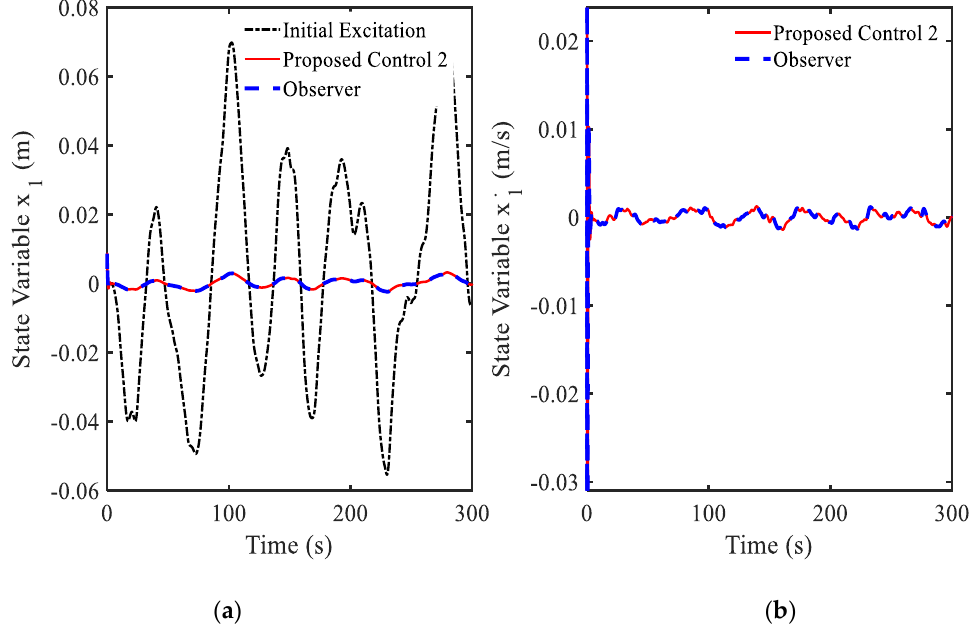
Figure 11. Vibration control results at the driver position under random bump road excitation: ( a ) displacement, ( b ) velocity.